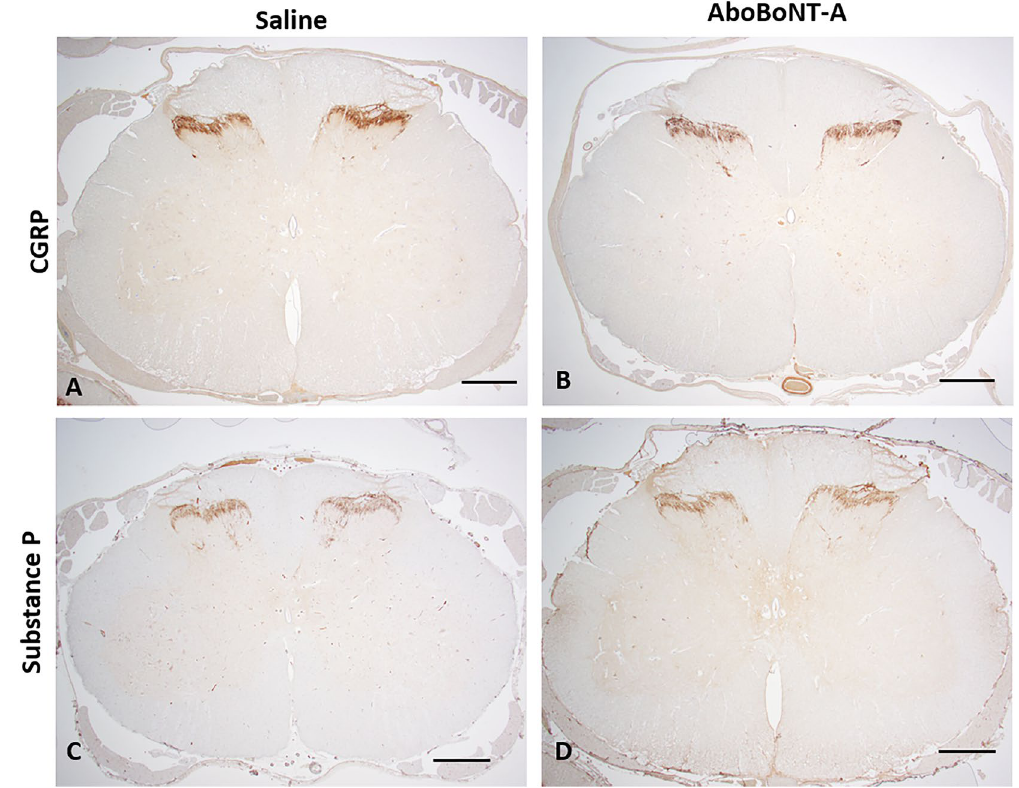
Figure 7. CGRP and SP immunolabelling in the lumbar spinal cord of saline- and aboBoNT-A-treated animals. Photomicrographs are taken from L5-L6 sections taken from representative animals that received a full-skin and muscle incision and retraction surgery (Day 0), followed by intraoperative treatment with either saline ( A, C ) or aboBoNT-A 400U ( B, D ) and tissue collection on Day 6. Scale bars: 1 mm. CGRP, calcitonin gene-related peptide; SP, Substance P; AboBoNT-A, abobotulinumtoxinA; U,